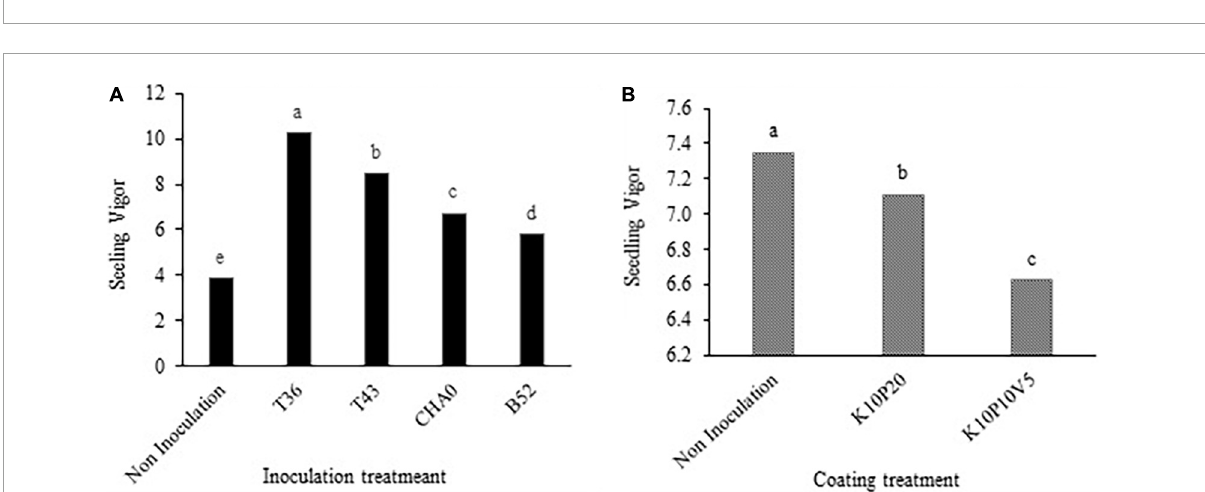
FIGURE4 Mean comparison of the effect of (A) seed inoculation and (B) seed coating on the seedling vigor of anise seeds. Means with the same letter are not significantly different according to the HSD test at P = 0.05. CHA0, B52 of Pseudomonas fluorescens , T36 and T43 of Trichoderma harzianum isolates. K, kaolin; V, vermiculite; P,